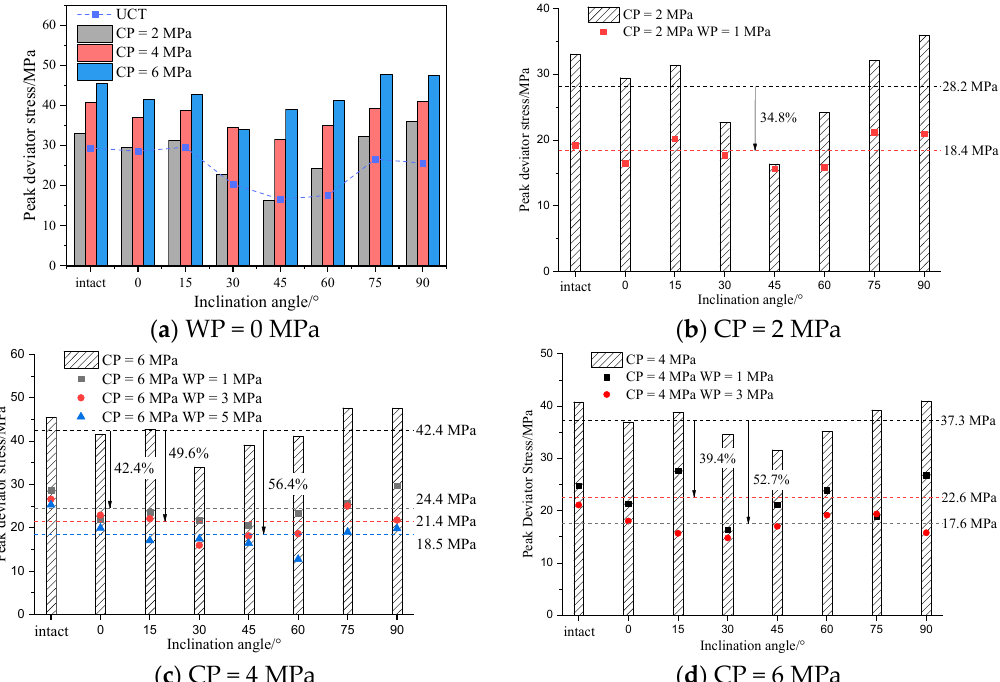
Figure 6. Results of the peak deviator stress. ( a ) Uniaxial compression test and conventional triaxial compression test; ( b ), ( c ), and ( d ) hydraulic coupled triaxial compression test under 2 MPa, 4 MPa, and 6 MPa confining pressure, respectively.